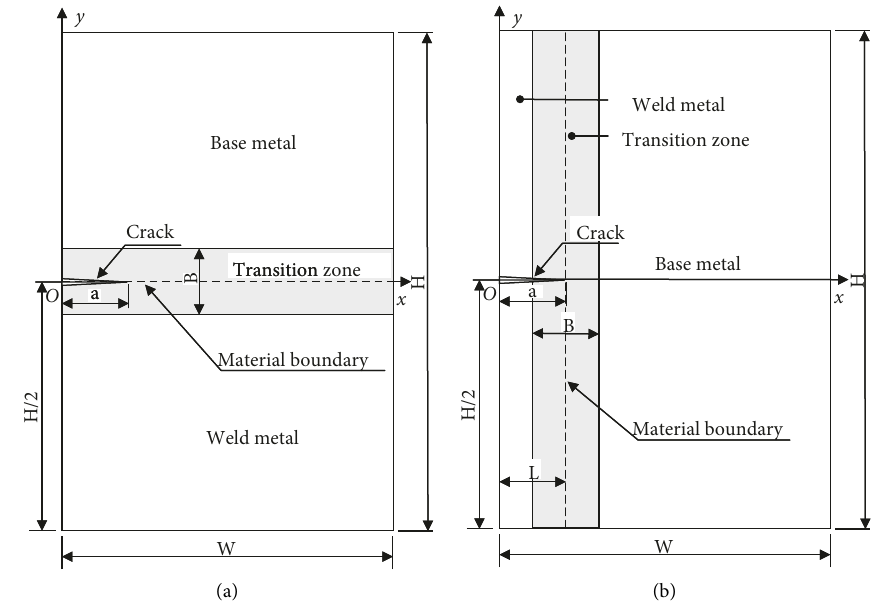
Figure 2: Schematic diagram of finite element model of welded joint. (a) The yield strength changes in the y -direction. (b) The yield strength changes in the x